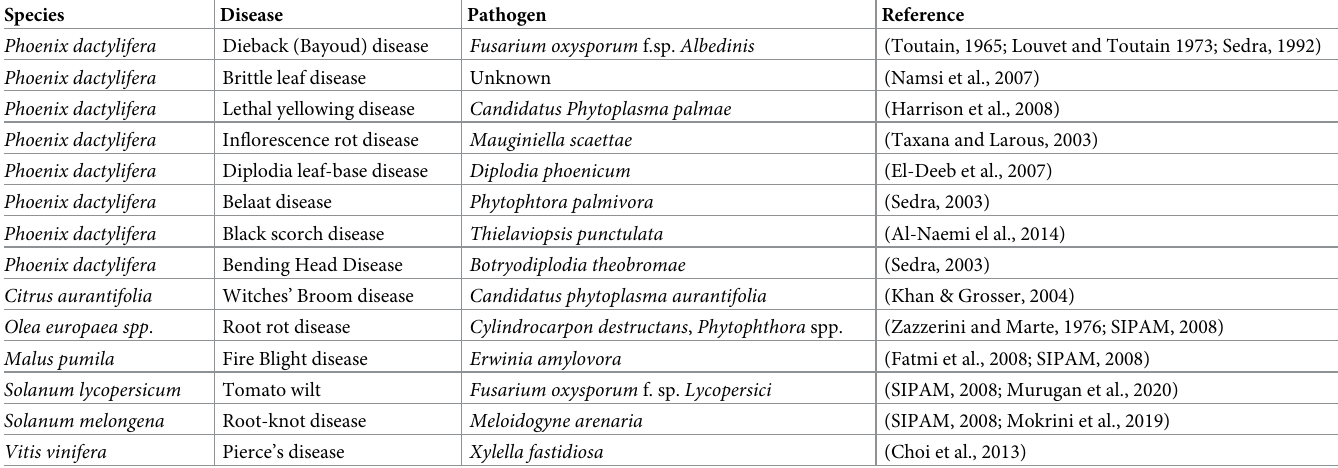
Table 1. Emerging infectious plant diseases in natural